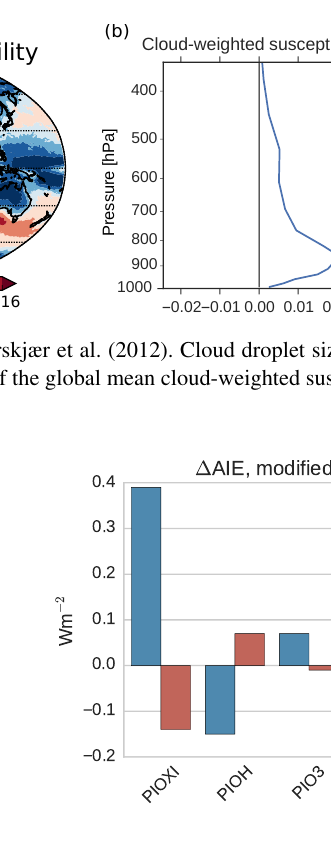
Figure 11. Differences in global mean shortwave and longwave aerosol indirect effect between the setups with modified PI simu- lations (PIOXI, PIOH, PINO3 and PIHO2) and the original